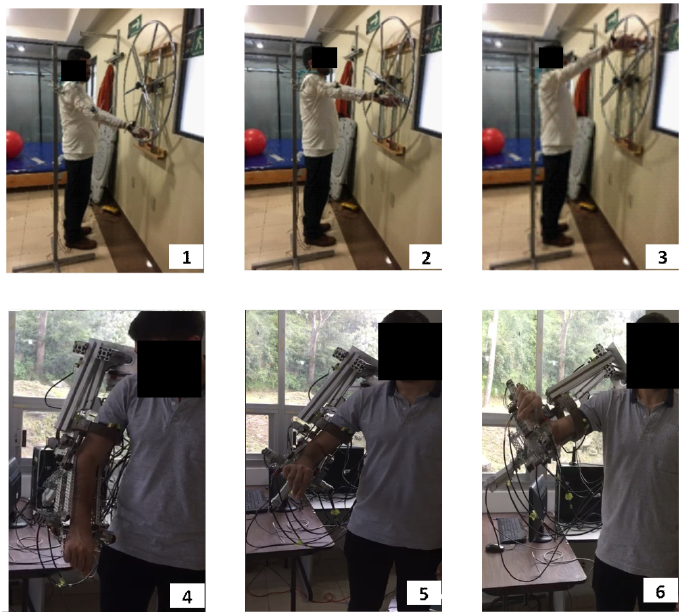
Figure 13. The rehabilitation protocol case 1 and data acquisition.